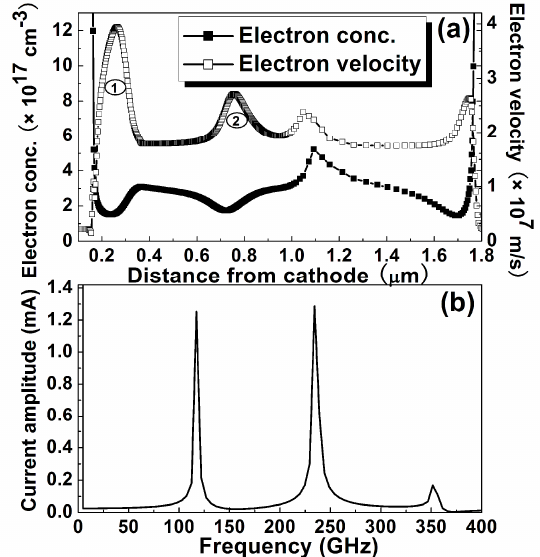
Figure 12. ( a ) The relationship of the electron velocity and electron concentration derived inside on oscillation circle at 12.6 ns, when L ac = 1.4 µ m, N ac = 3 × 10 17 cm − 3 ; ( b ) and its frequency spectrum